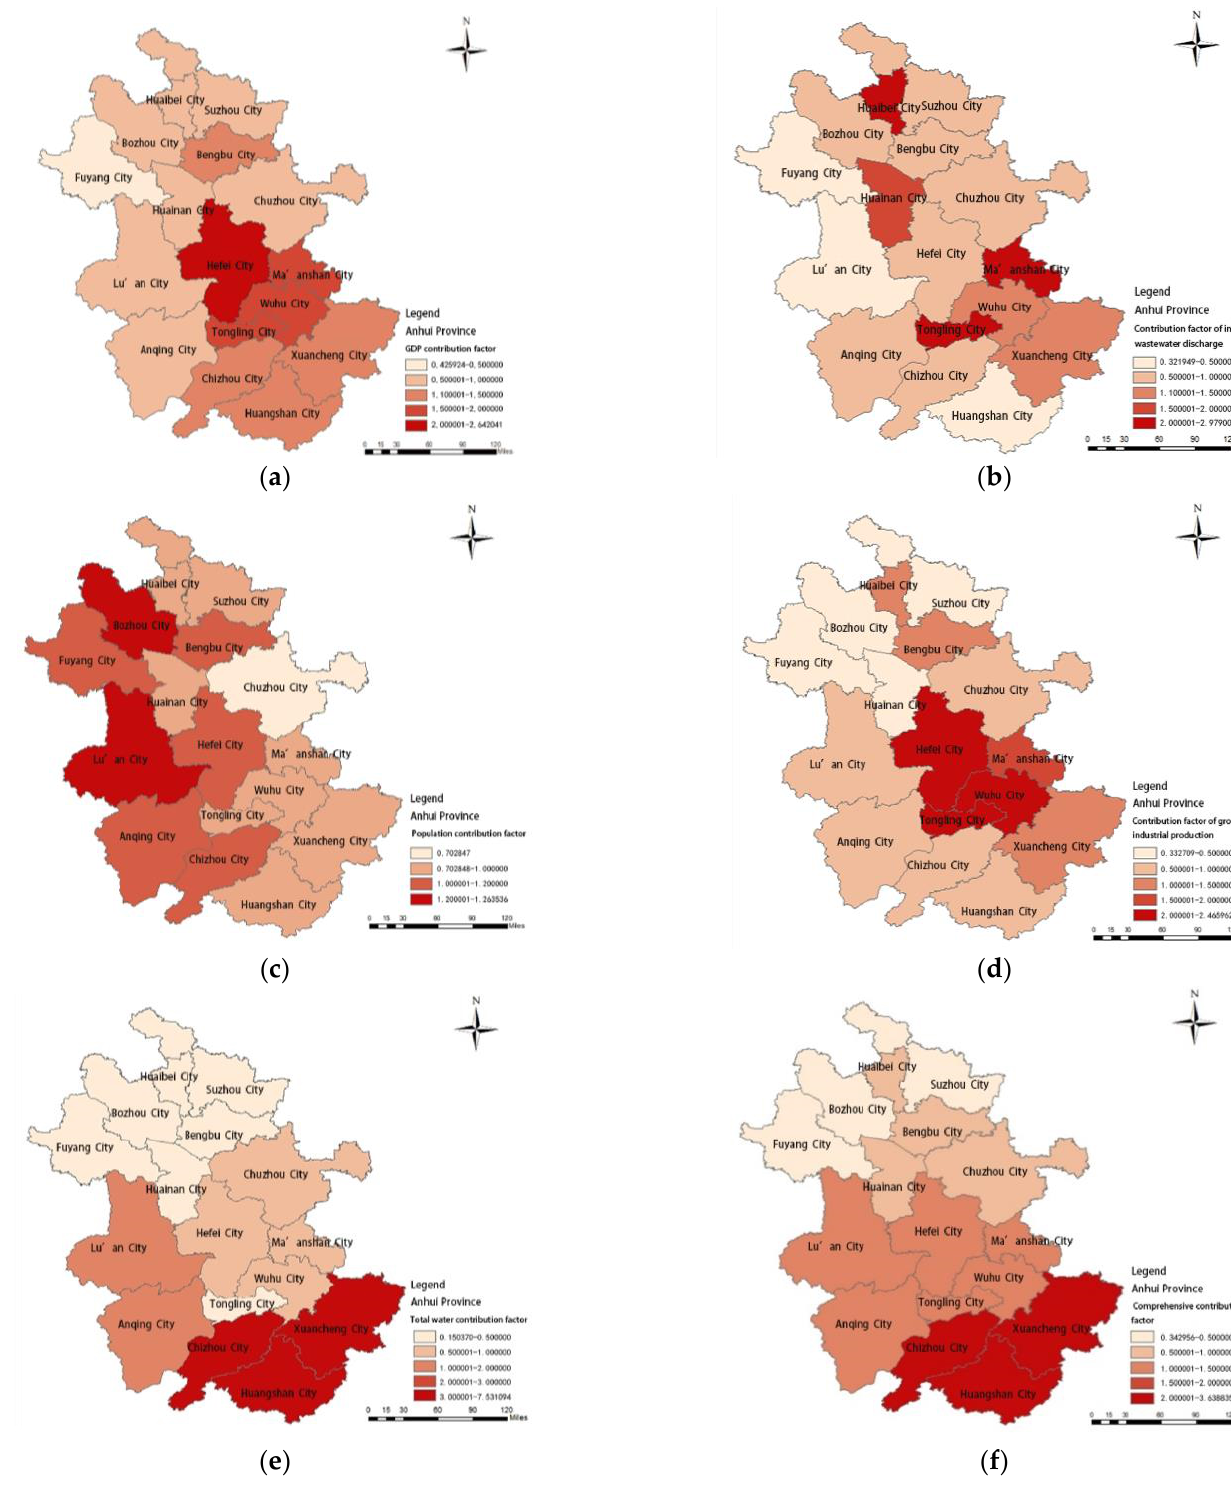
Figure 9. Distribution of NH 3 -N index contribution coefficient in Anhui Province in the benchmark year. ( a ) GDP contribution factor. ( b ) Contribution factor of industrial wastewater discharge. ( c ) Population contribution factor. ( d ) Contribution factor of gross industrial production. ( e ) Total water contribution factor. ( f ) Comprehensive contribution factor.